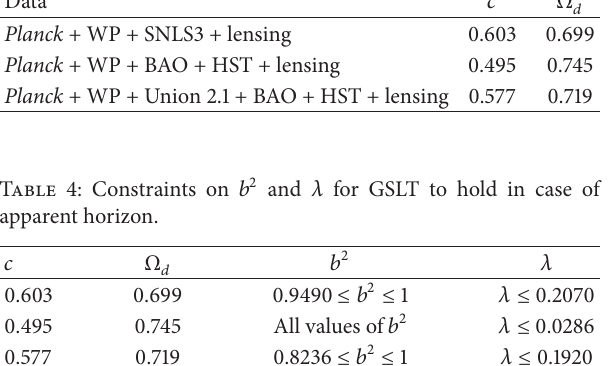
Table 5: Constraints on 𝑏 2 and 𝜆 for GSLT to hold in case of event